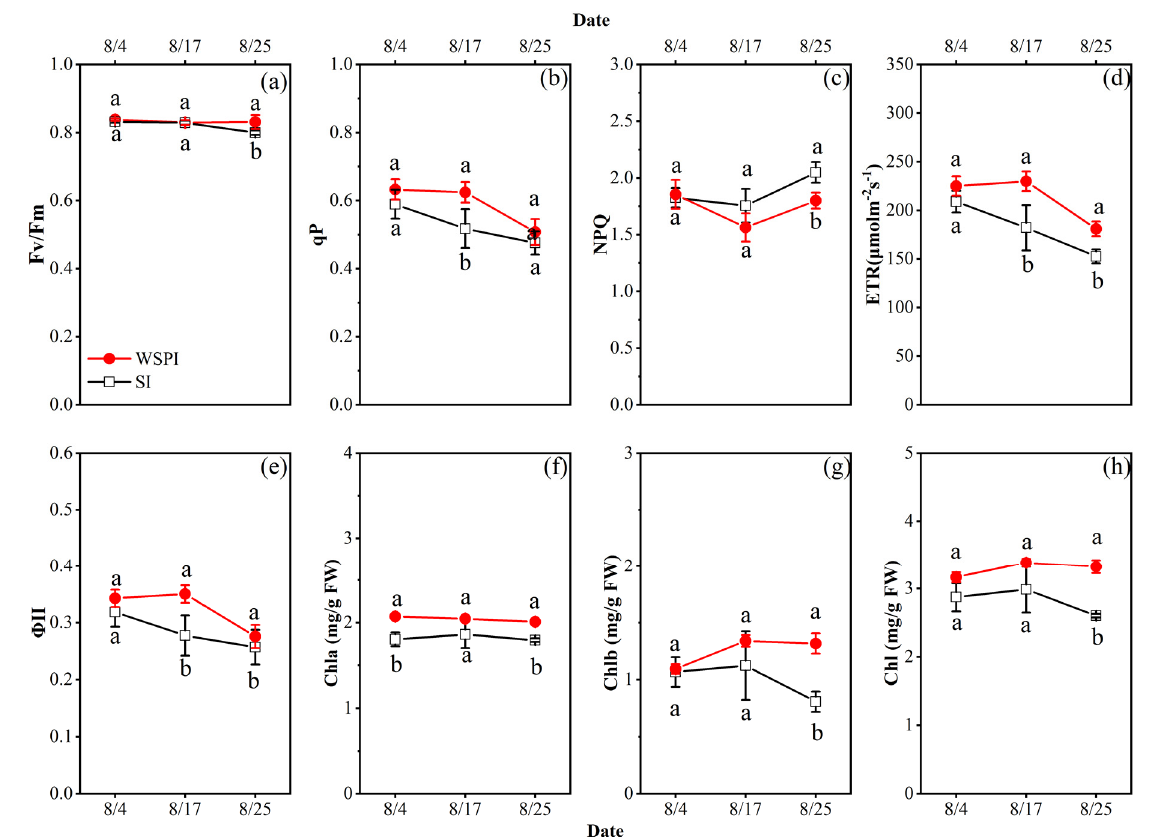
Figure 7. The potential quantum yield of PSII (Fv/Fm, shown in a ), photochemical quenching (qP, b ), non-photochemical quenching (NPQ, c ), actual quantum yield ( Φ II, d ), ( e ) electron transport rate (ETR, e ), and chlorophyll content ( f – h ) of apple leaves under water storage pit irrigation (WSPI) and surface irrigation (SI) during the August of 2017. The Bars indicate standard errors of the mean ( n = 3 for chlorophyll content parameters, and n = 9 for chlorophyll fluorescence parameters); the same letters in figure indicate nonsignificant differences between the treatments, whereas different letters show significant differences ( p < 0.05).